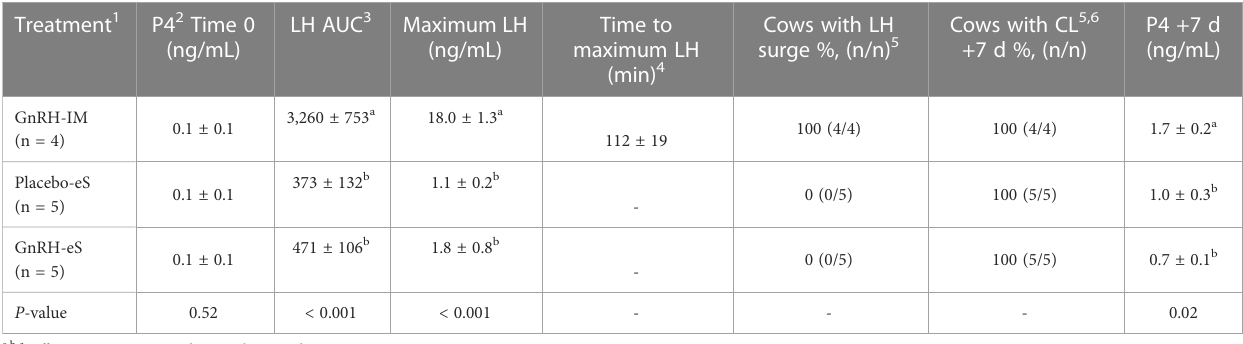
TABLE 1 Circulating concentrations of progesterone (P4) at 0 h relative to treatment administration, luteinizing hormone (LH) secretion dynamics, and ovulation after treatment in Experiment 1. Treatment